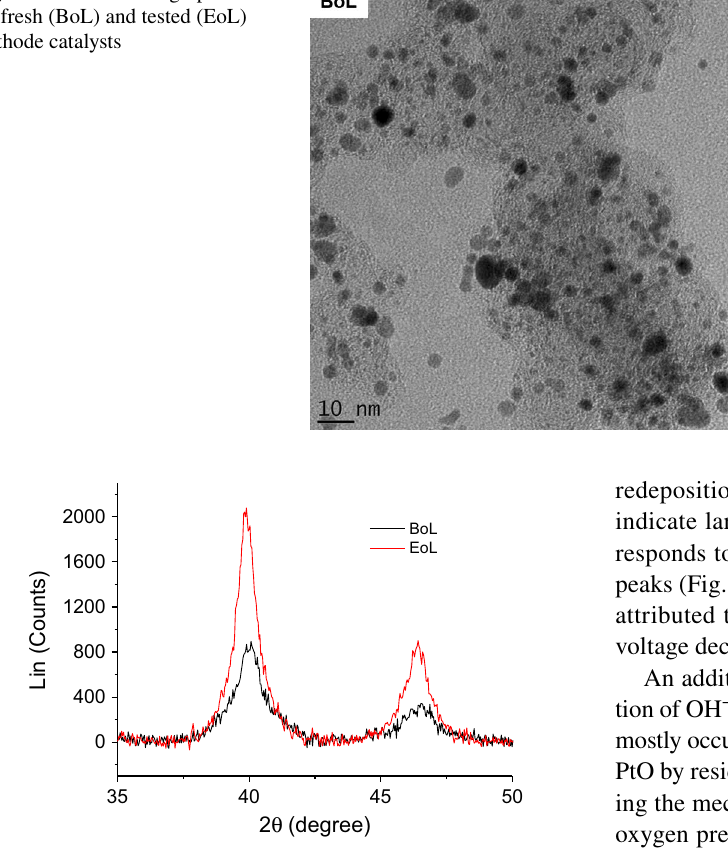
Fig. 7 HR-TEM micrographs of fresh (BoL) and tested (EoL) cathode catalysts